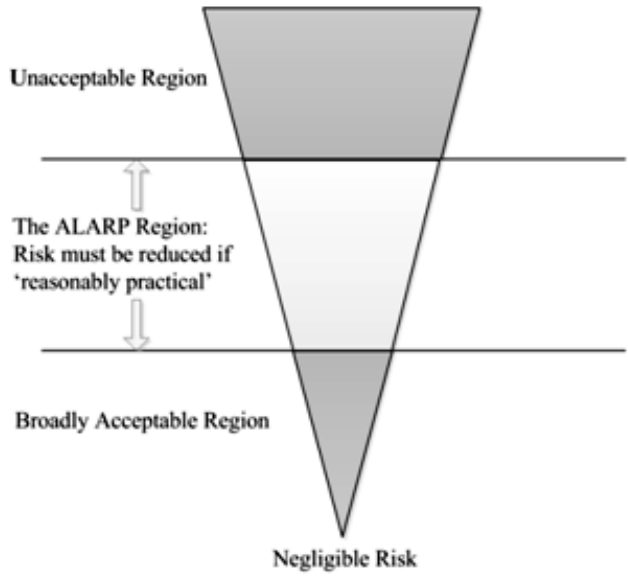
Figure 7. Risk Levels and the Concept of